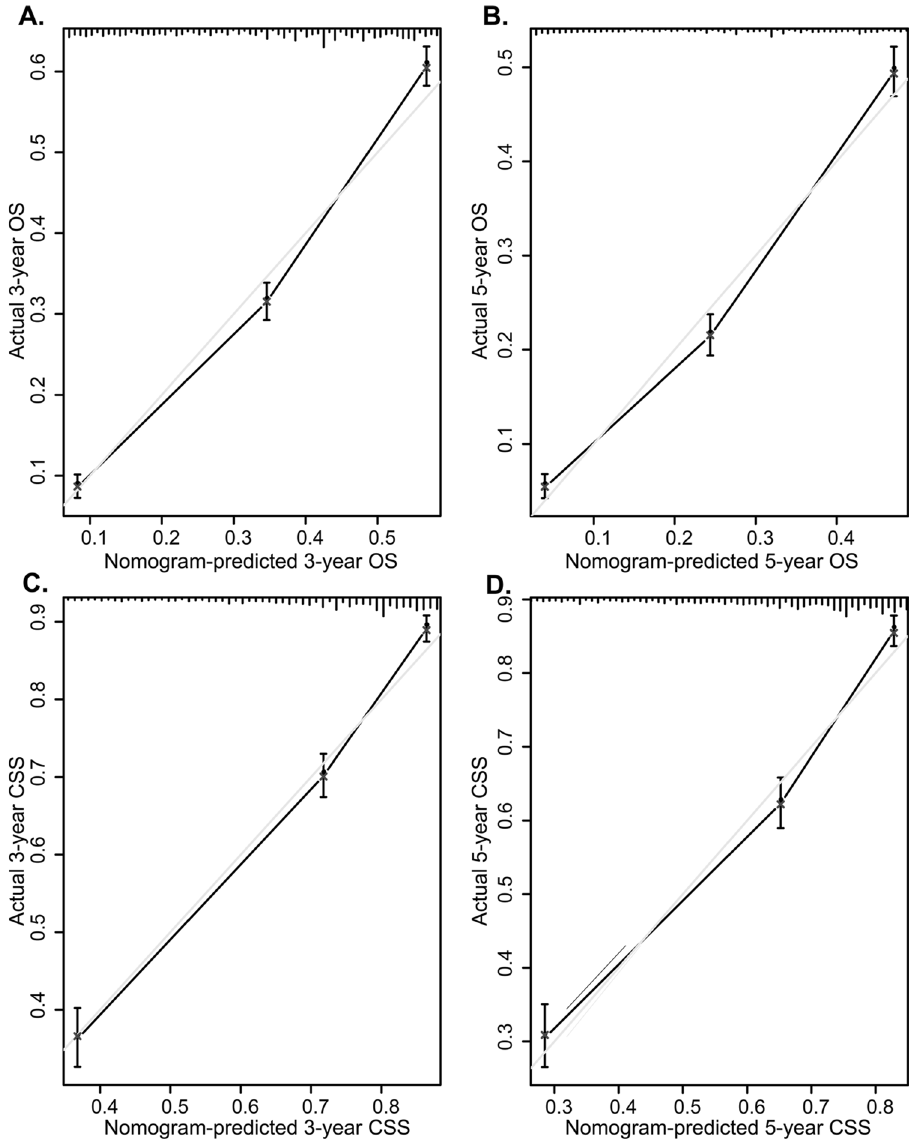
Figure 5. Calibration plot of the nomogram for predicting 3-, 5-, and 10 ‐ year overall survival (OS) and cancer- specific survival (CSS) in the training cohort. ( A ) 3-year OS; ( B ) 5-year OS; ( C ) 3-year CSS; ( D ) 5-year